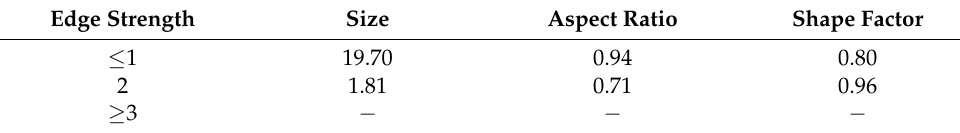
Figure 7. Three images of the same particle with a THV = 62, but with different ESVs: ( a ) ESV ≤ 1; ( b ) ESV = 2; ( c ) ESV ≥ 3. Associated results are shown in Table 4. Table 4. Associated results to Figure